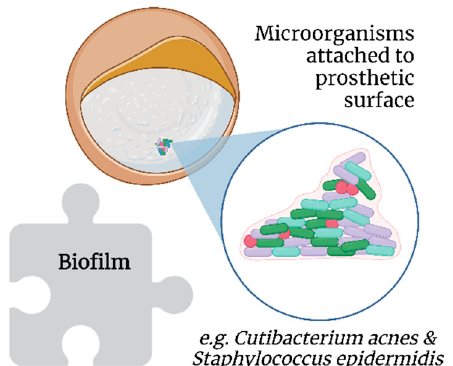
Figure 4. Association of biofilms with breast implant illness.